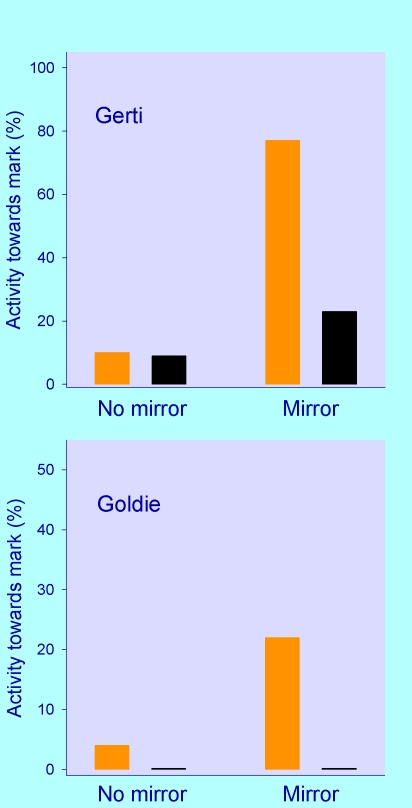
Proportion of Self-Directed Behavior towards the Mark Area Expressed as a Proportion of Overall Self-Directed Behavior in Subjects Gerti and GoldieOrange bars refer to tests with a colored mark (yellow or red), black bars to tests with a black control mark (sham condition). In Gerti (p < 0.005, Fisher exact test), as well as in Goldie (p < 0.05, Fisher exact test), mark-directed behavior was significantly enhanced in the colored mark and mirror condition.